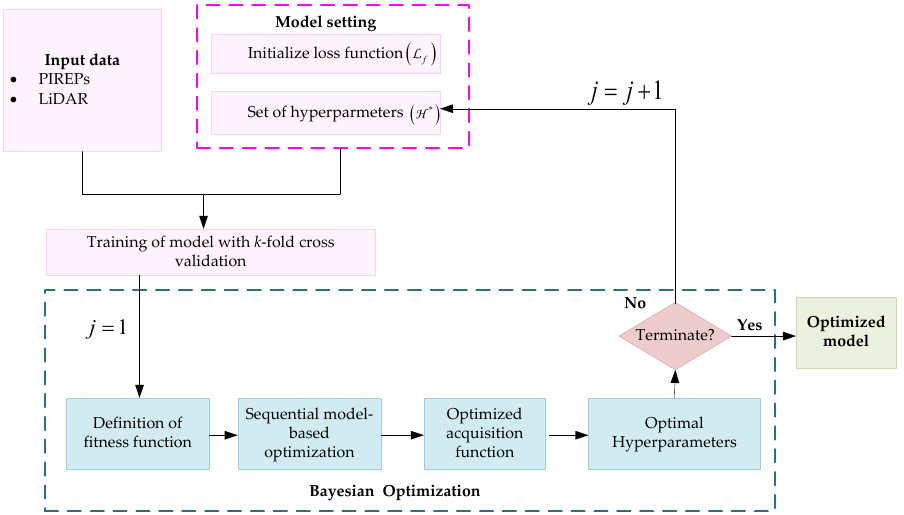
Figure 3. Bayesian approach for hyperparameters tuning.